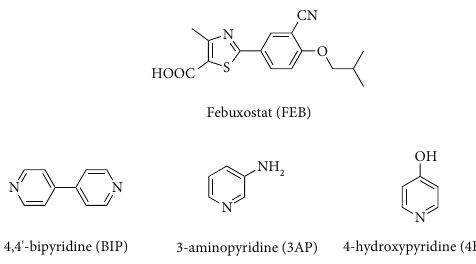
Figure 1: Chemical structures of FEB and